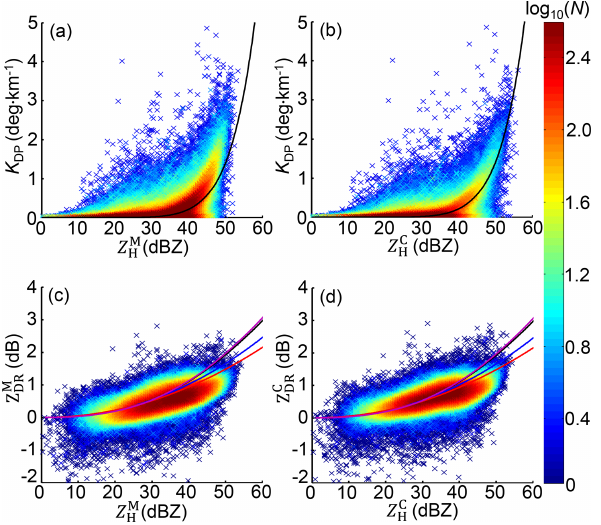
Figure 9. The scattergram between polarimetric measurements from the WZ-SPOL radar, (a) K DP vs. Z M , (b) K DP vs. Z C , H H (c) Z M vs. Z M , and (d) Z C vs. Z C . Measurements of all six DR H DR H stations derive the black curves; the blue, red, and purple curves in Figure 10. (a) Time series of radar-measured Z C (c) and (d) stand for Eqs. (11a)–(11c) derived from S I – S III . derived Z H at the six meteorological stations shown in Fig. 6 dur- ing 22:00UTC, 8 August 2019, and 04:00UTC, 10 August 2019. (b) Similar to (a) , but for radar-measured K DP and DSD-derived K DP . (c) Similar to (a) , but for radar-measured Z C derived Z DR